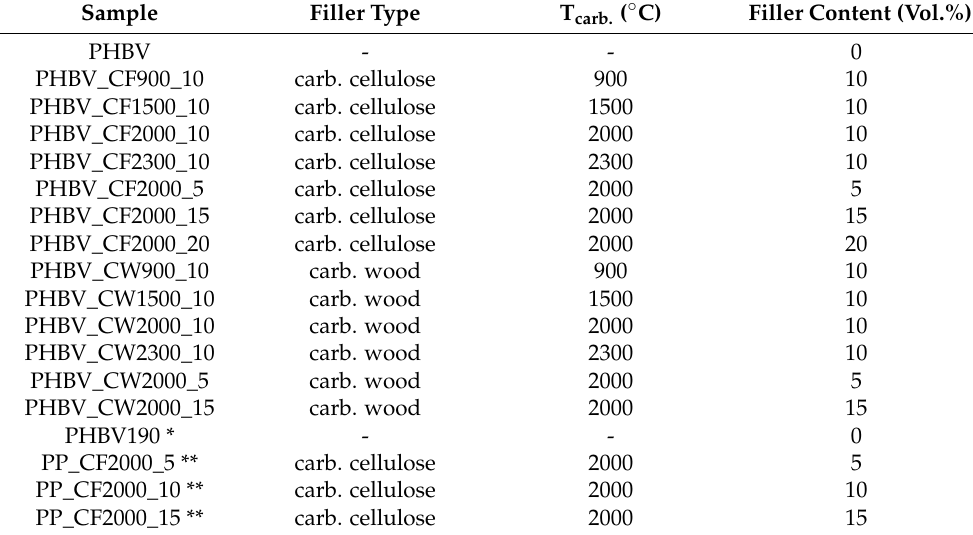
Table 1. Overview of the prepared